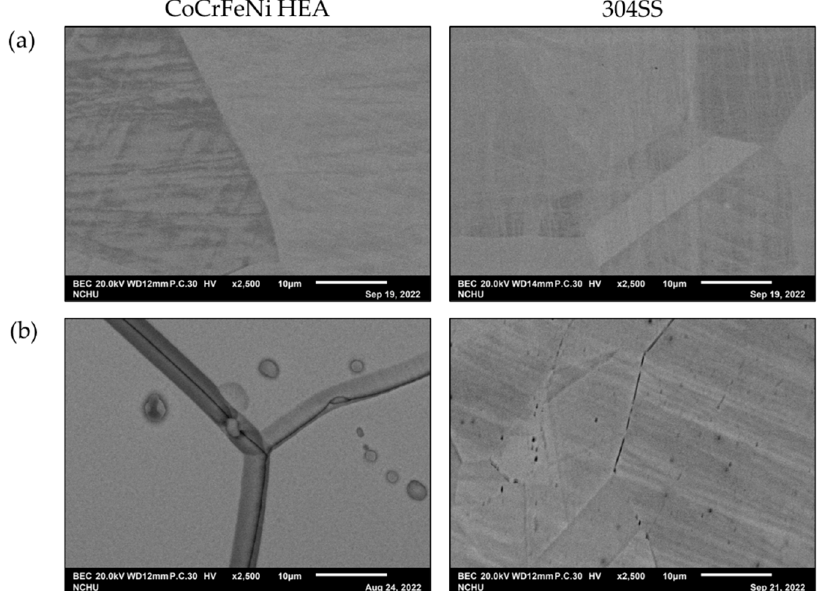
Figure 5. SEM observations of CoCrFeNi HEA and 304SS ( a ) before and ( b ) after potentiodynamic tests.